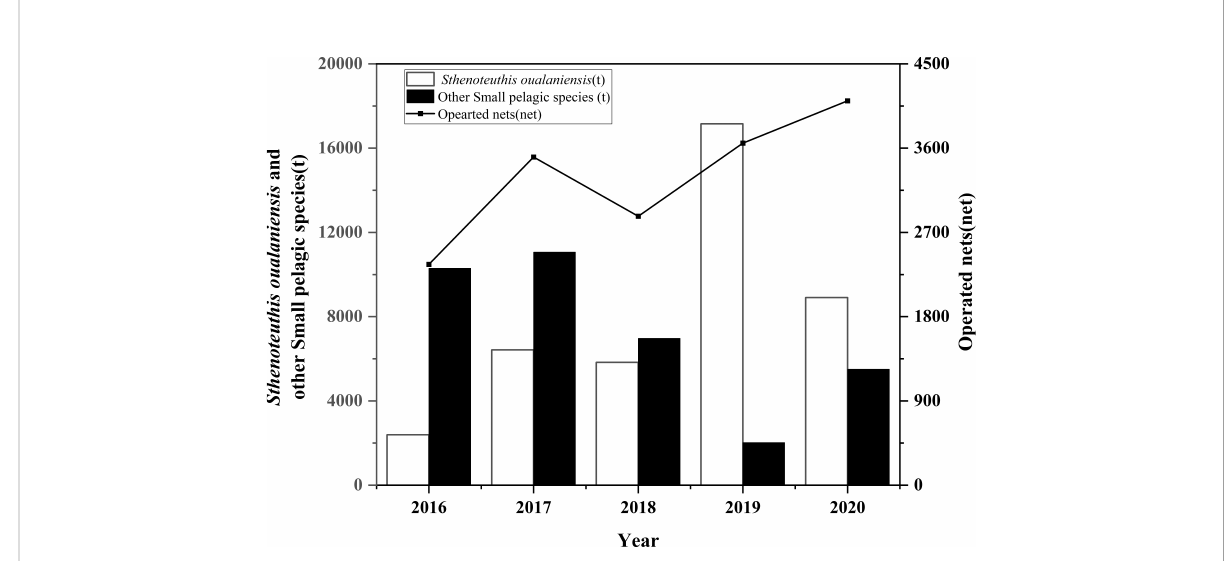
FIGURE 1 Changes in the main catches and operated nets for light falling gear in the northwest Indian Ocean from 2016 to